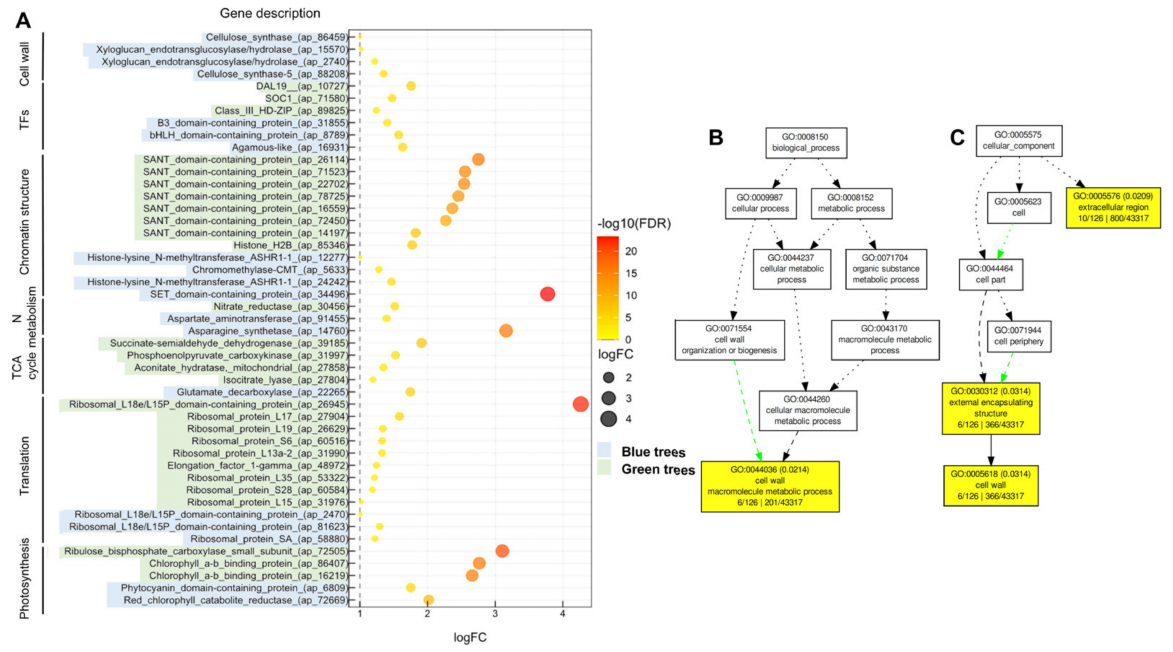
Figure 2. Transcriptome analysis on the needles from bluish and green trees. ( A ) Graphical represen- tation of differentially expressed (DE) transcripts based on their representation (logFC) and statistical significance ( − log10 FDR) regarding different cellular processes/pathways. Singular enrichment analysis (SEA) of the GO terms was made in the AGRIGO v2.0 web tool under standard parameters using as GO term reference the whole assembled transcriptome annotation. Blue-labeled transcripts correspond to a higher abundance of DE transcripts in needles from bluish trees. Green-labeled tran- scripts correspond to a higher abundance of DE transcripts in needles from green trees. ( B ) Significant GO biological process terms from significant DE transcripts after a SEA analysis. ( C ): Significant GO cellular component terms from significant DE transcripts after a SEA analysis. The harvesting of needles from six independent green and bluish trees was carried out in April 2021 at Hoyo Mill á n at 1080 m